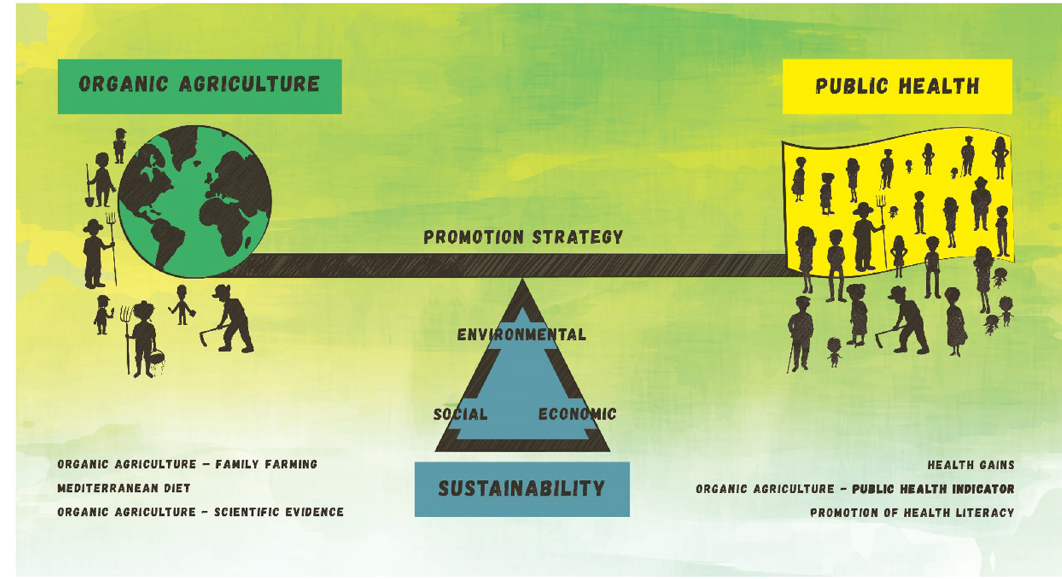
Figure 2: Proposal of organic agriculture as a public health